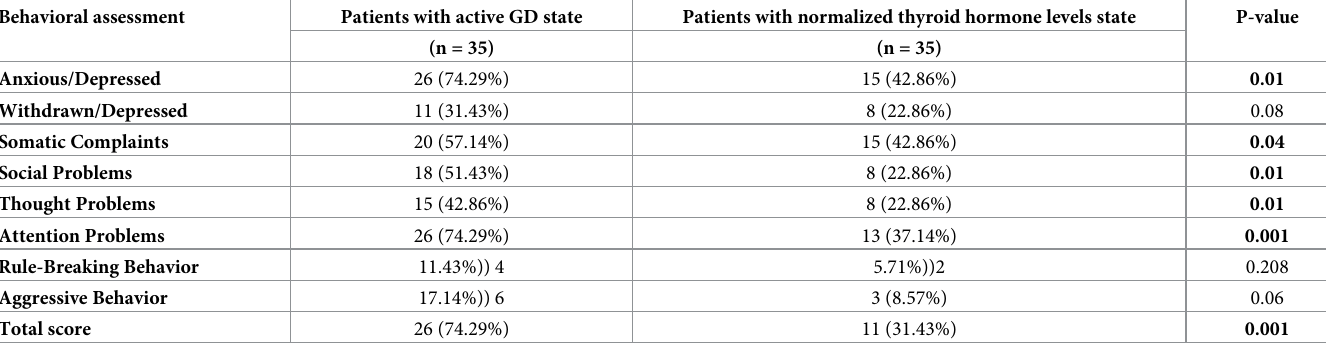
Table 3. Frequency of patients at or above the borderline clinical range for CBCL.